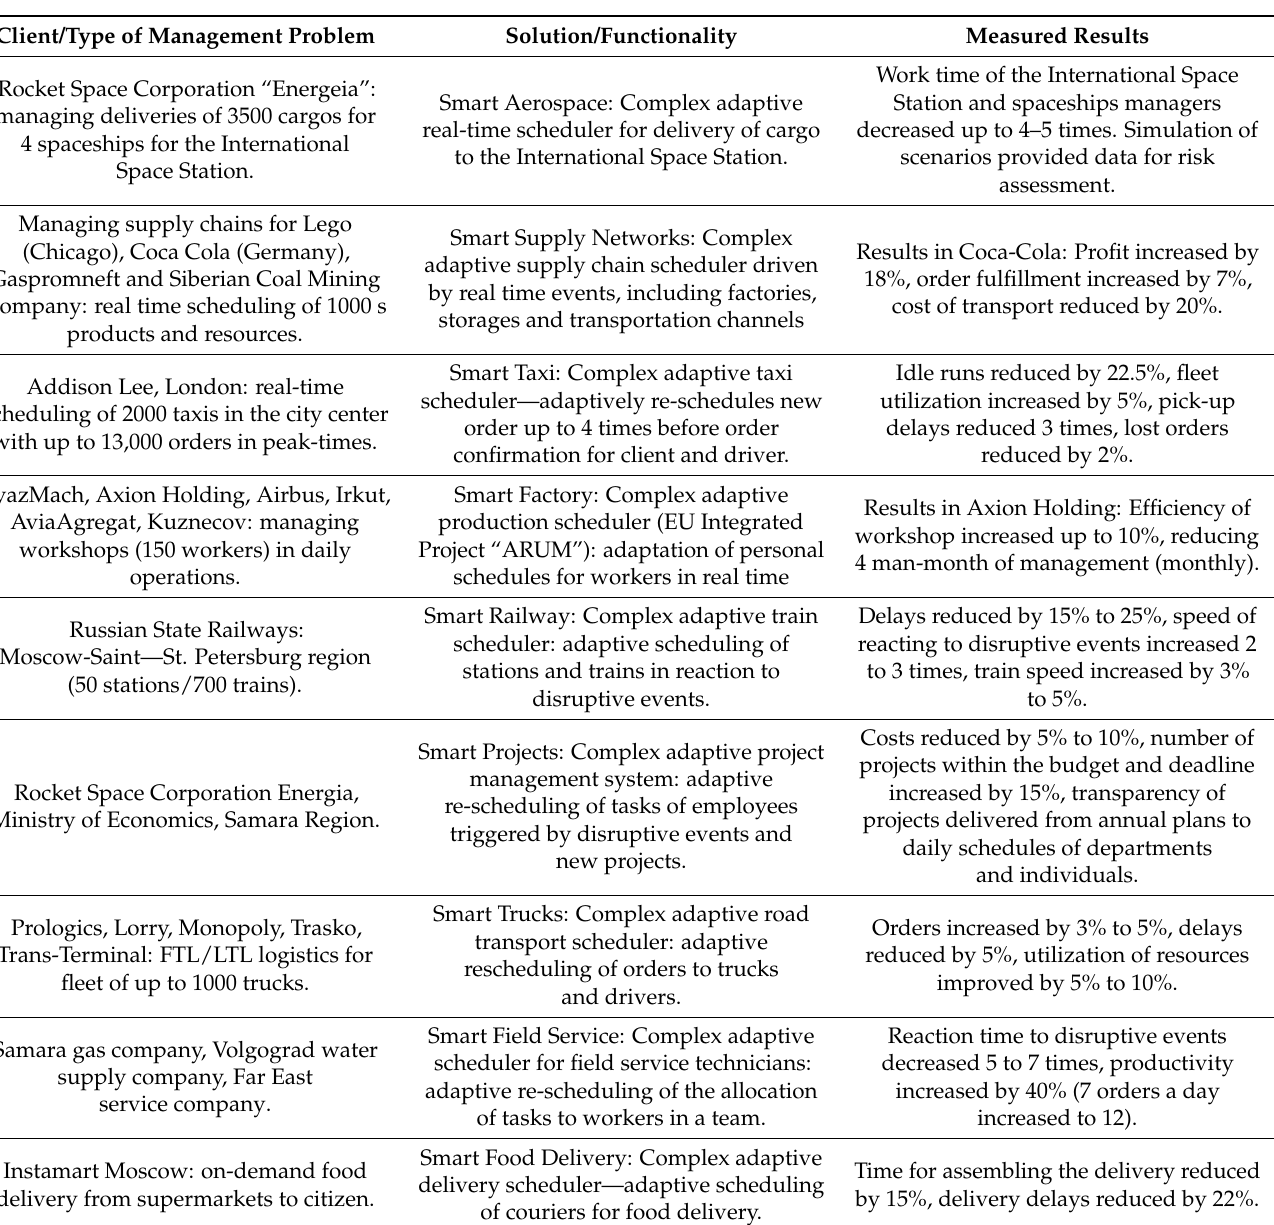
Table 8. A selection of industrial applications of complex adaptive systems exhibiting emergent intelligence, which were used to evaluate EI